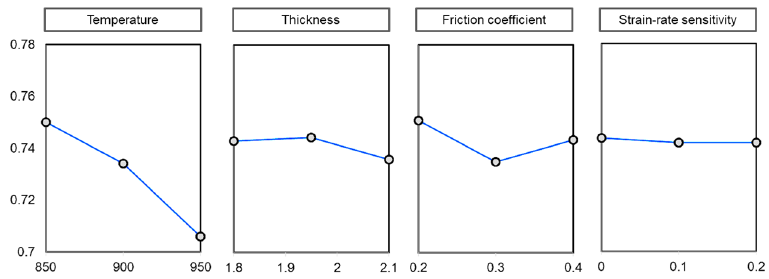
Figure 14. The position and minimum value of the martensite phase ratio at 30 s after stamping and die quenching for ( a ) part from sheet blank thickness of 1.8 mm and ( b ) part from sheet blank thick ‐ ness of 2.1 mm. 3. Text Correction There was an error in the original article. Data and Expressions provided by Hyundai Steel, which are not intended to be disclosed, were included in the text. A correction has been made to Section 2, Paragraph 4: The hot stamping test of T ‐ type parts was performed using the machined sheet blank as shown in Figure 2. The hot